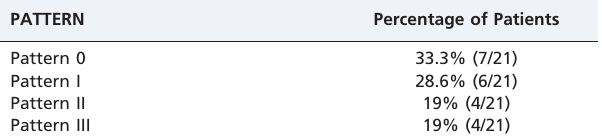
Table 4 - Distribution of Color Doppler patterns based on the classification initially created by Schulz et al. for hypothyroidism.